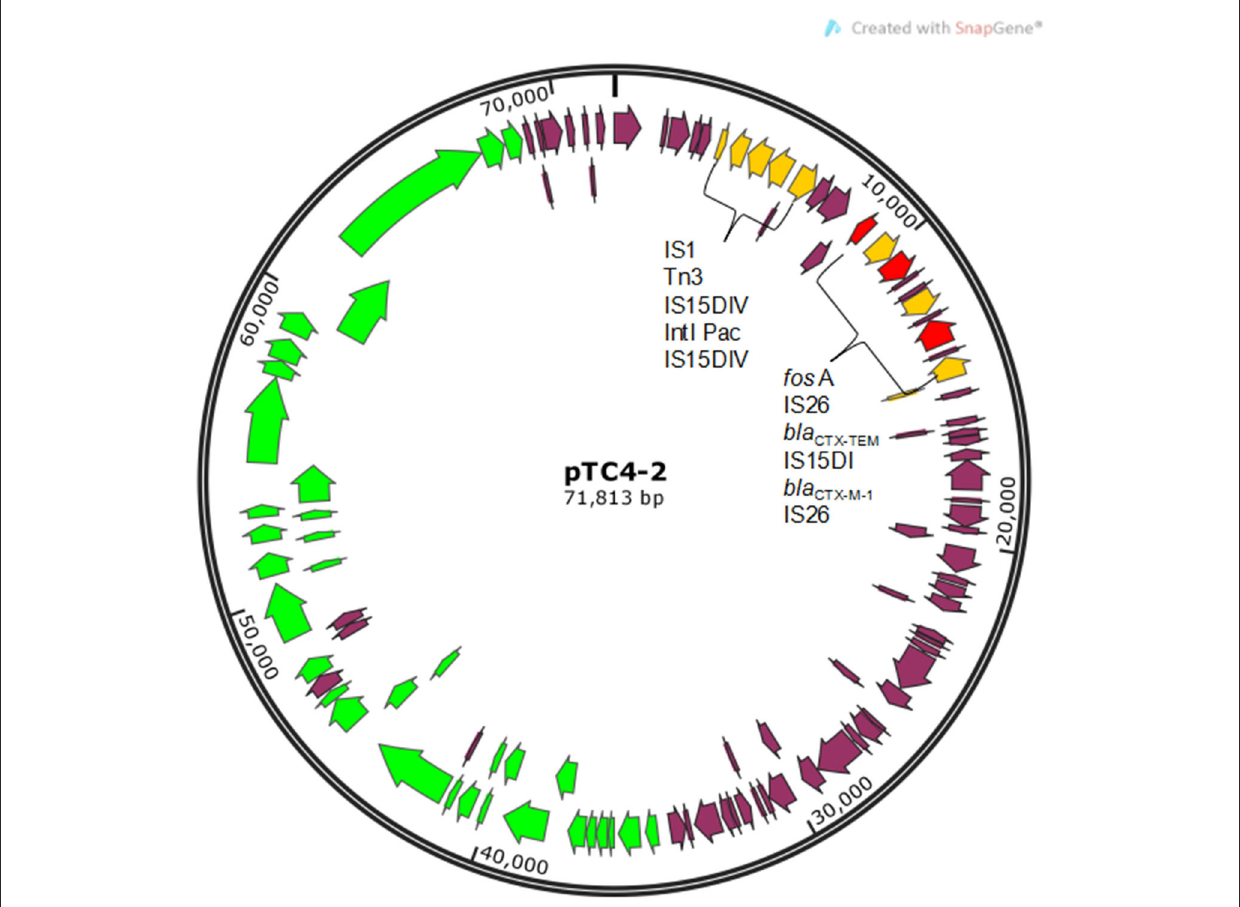
FIGURE1 Gene map of conjugative plasmid pTC4-2. Yellow arrows represent mobile elements. Red arrows represent resistance genes. Green arrows represent genes related to conjugal transfer functions.